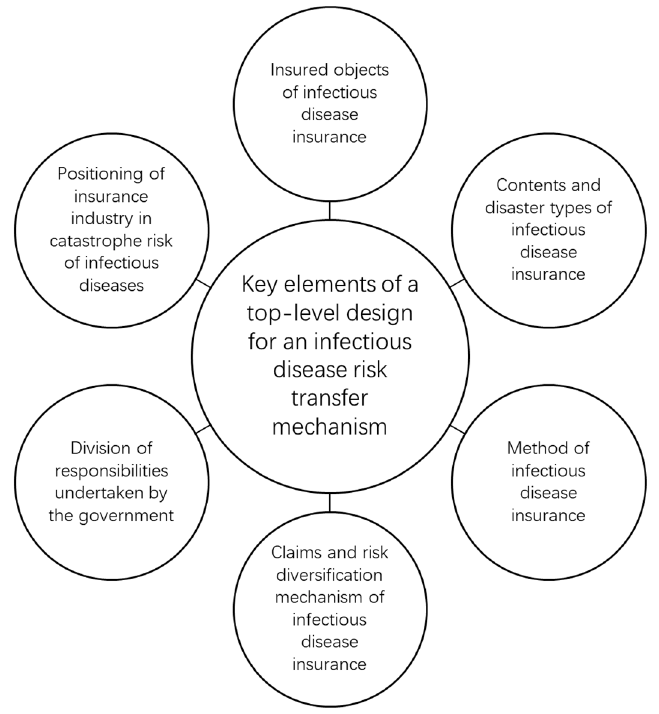
Figure 2. Top-level design of infectious disease risk transfer mechanism.